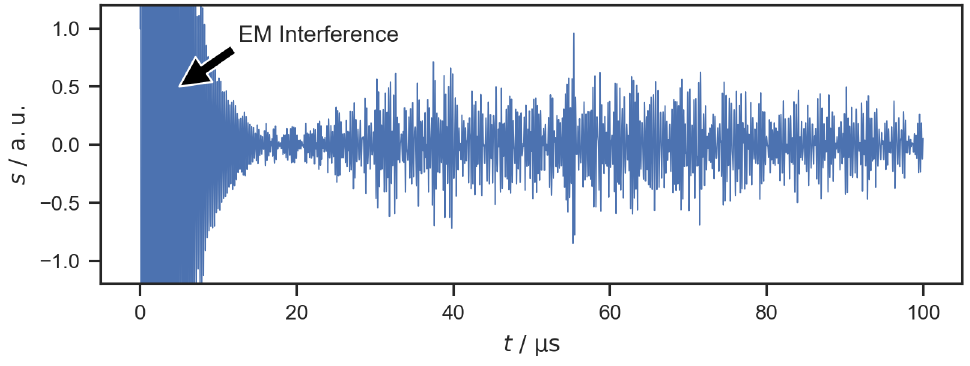
Figure 3. Filtered signal transmitted from PWAS 1 and received at PWAS 2. Electromagnetic (EM) interference occurs at the beginning of the